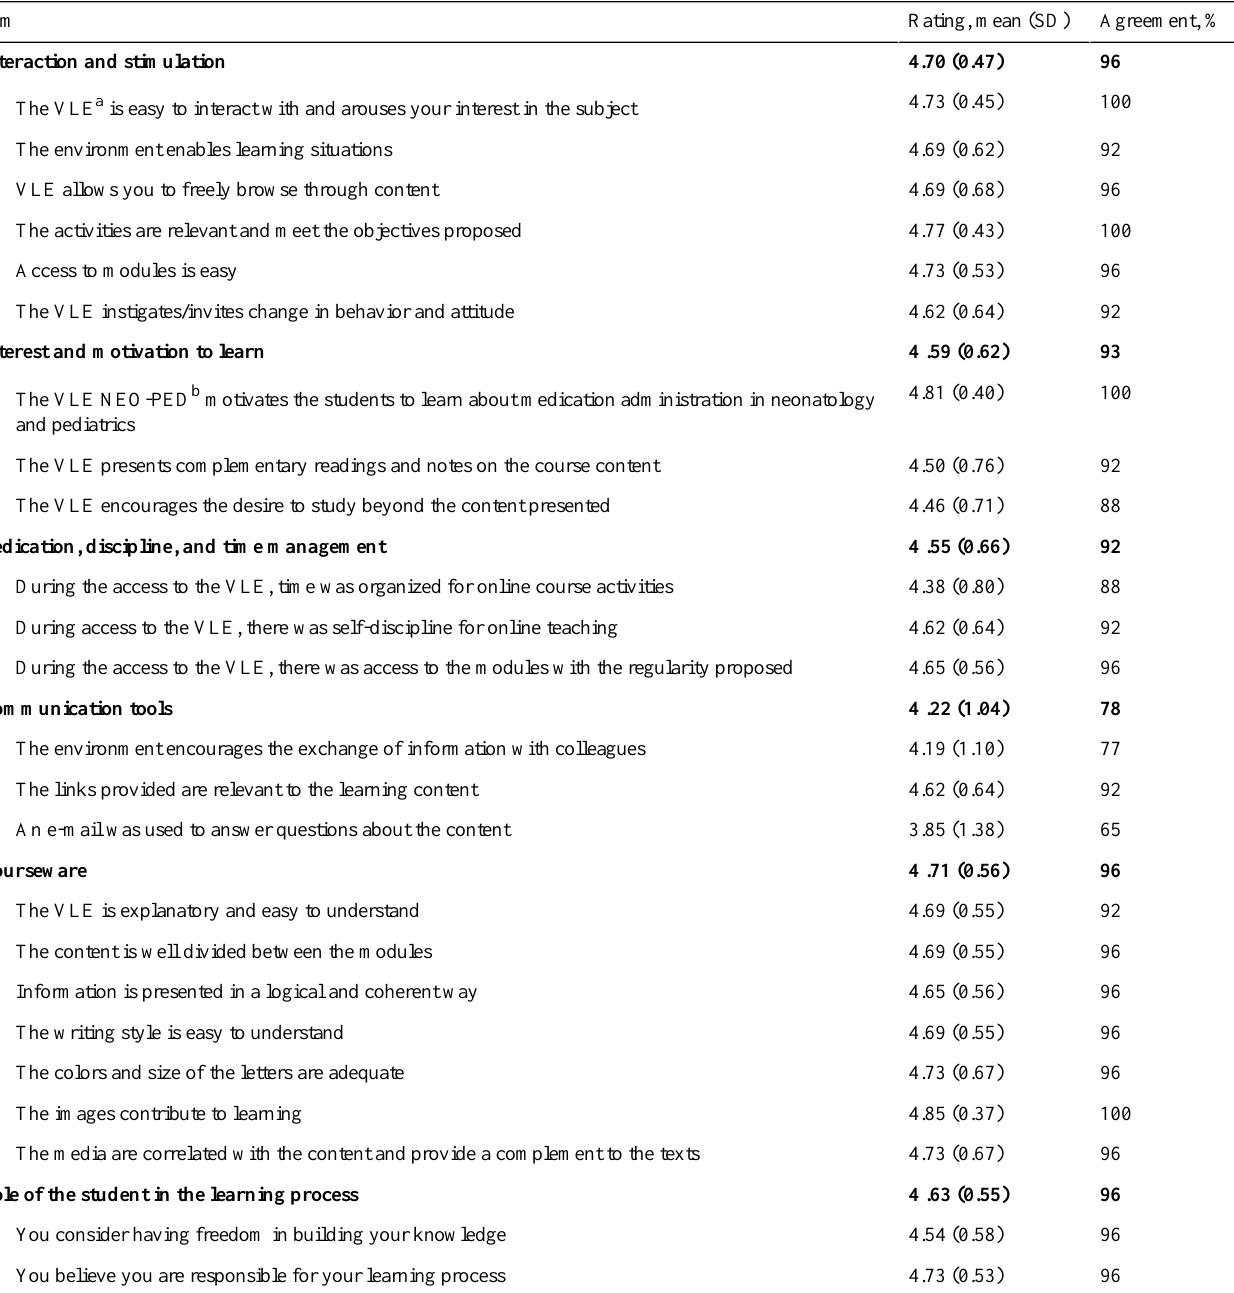
Table 3. Criteria evaluated by the users (n=26).